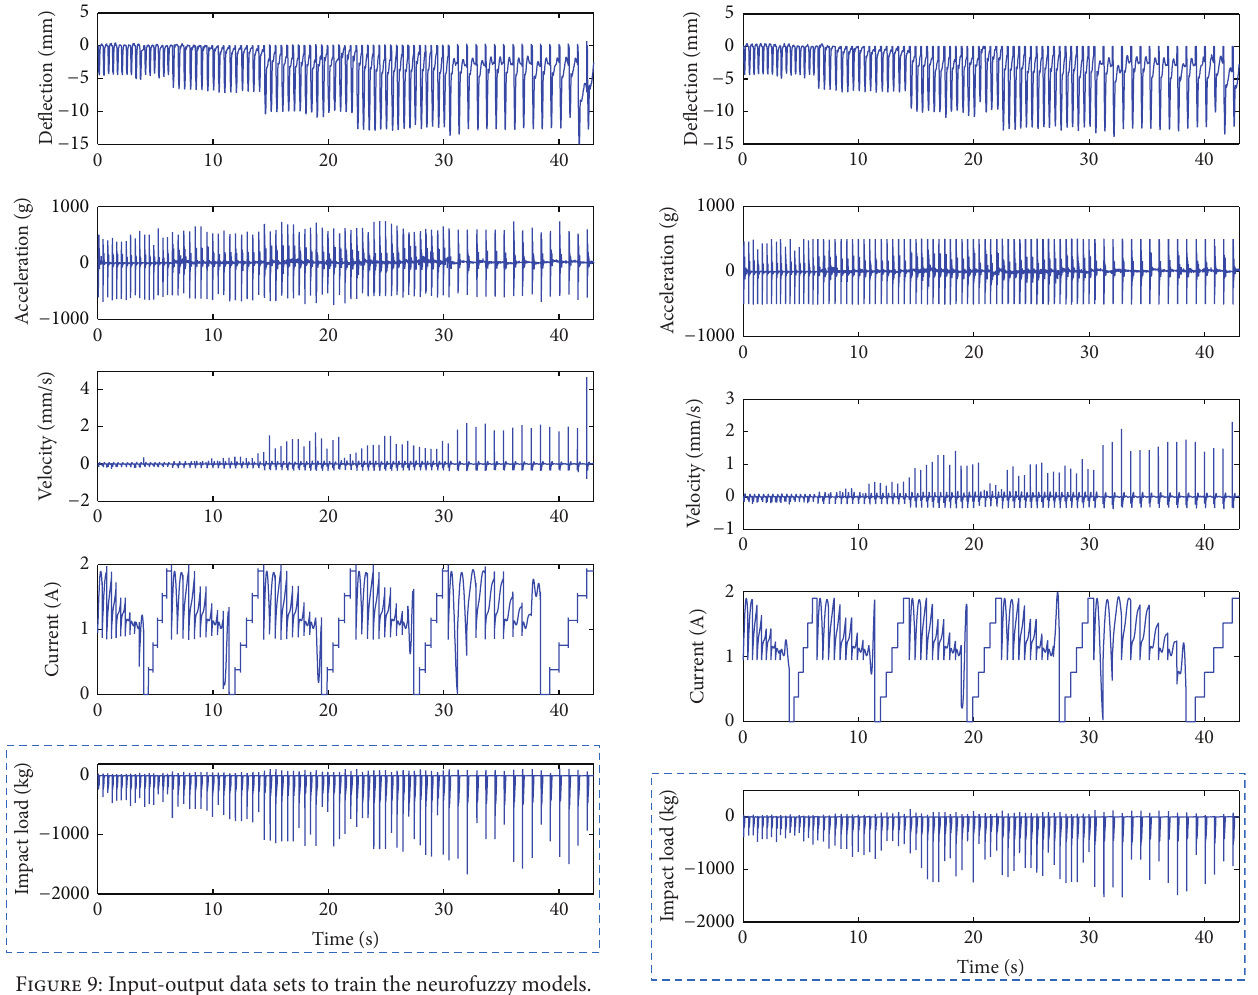
Figure 10: Input-output data sets to validate the neurofuzzy